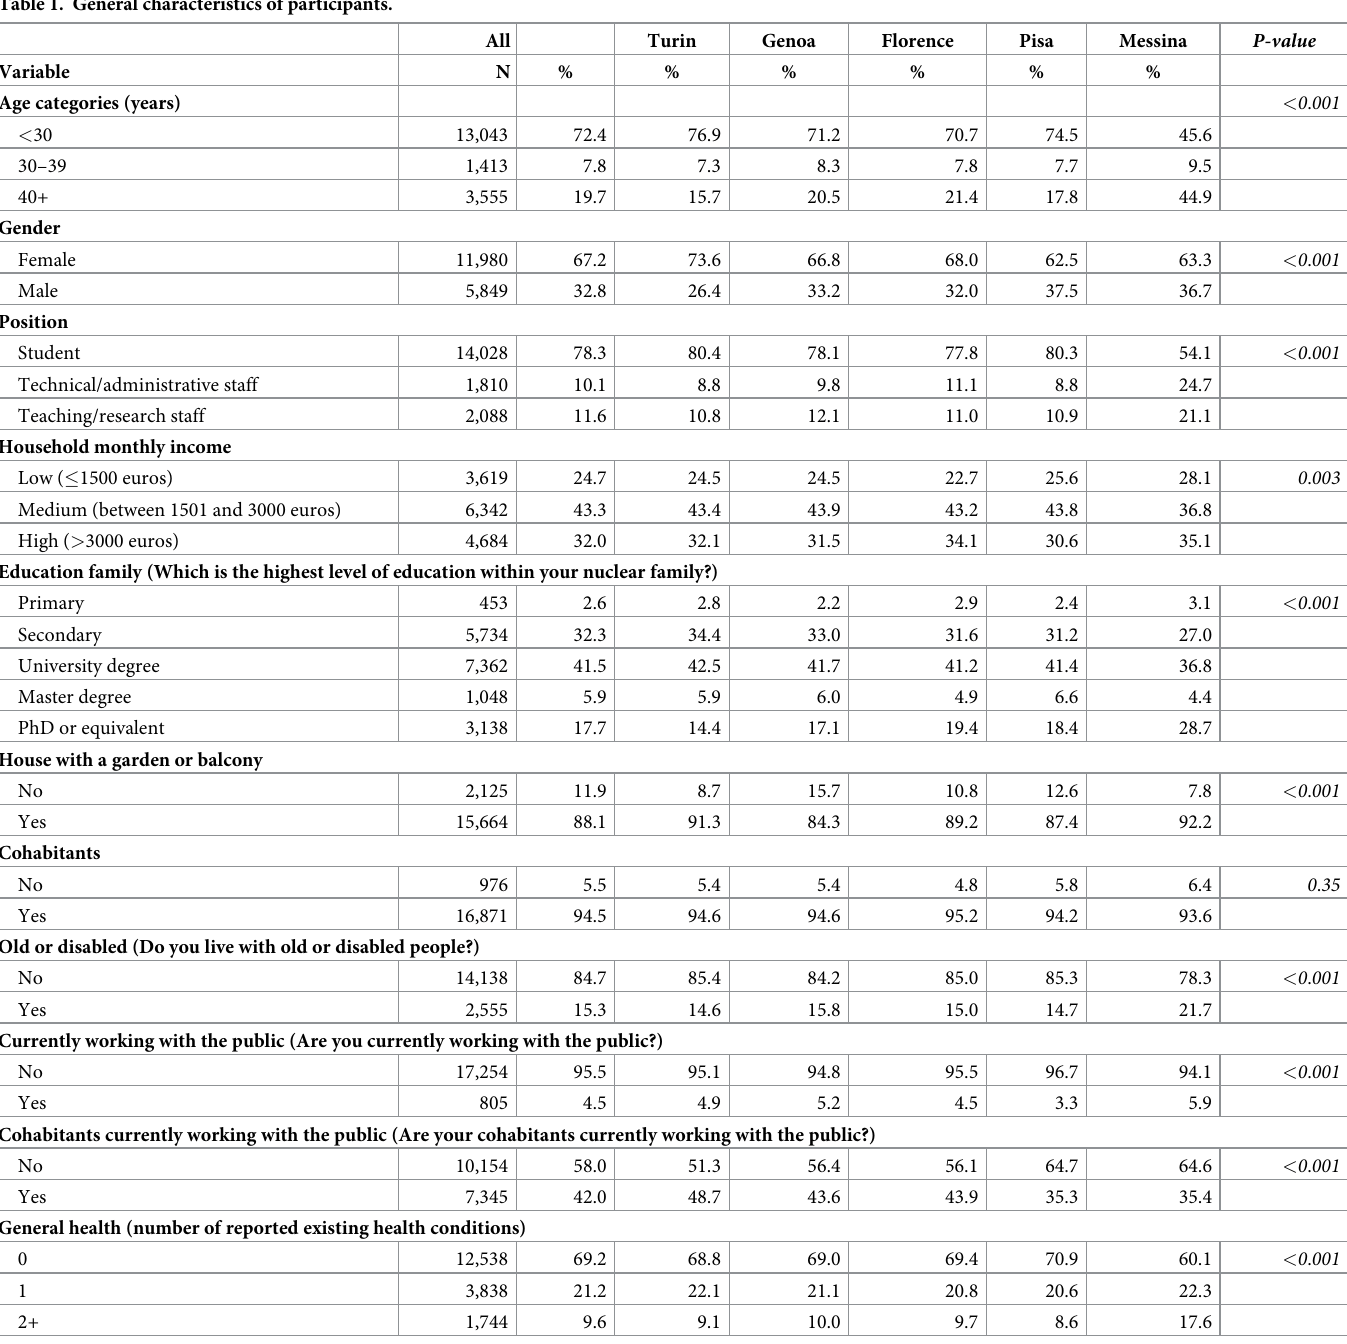
Table 1. General characteristics of participants.